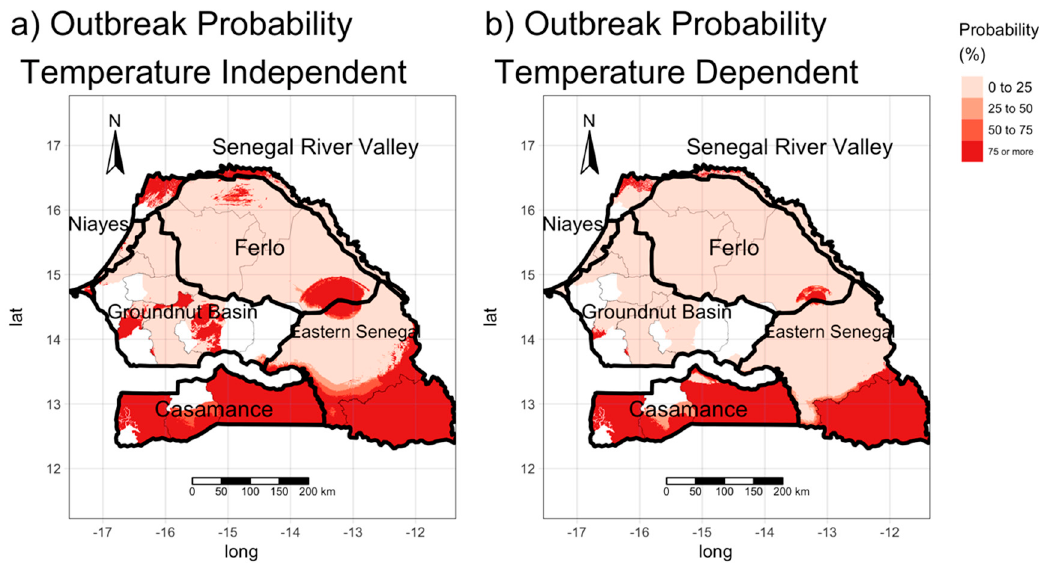
Figure 7. Probability of outbreaks due to the introduction of infected animals. ( a ) using R 0 temperature-independent values, ( b ) using R 0 temperature-dependent values. Livestock movements from infected areas could explain why areas with a low value of R 0 could have a high risk of outbreak occurrence. White areas correspond to areas where the outbreak probability has not been estimated because of missing information.